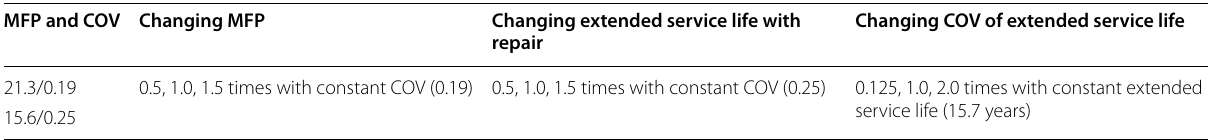
Table 4 Simulation of repair cost (control